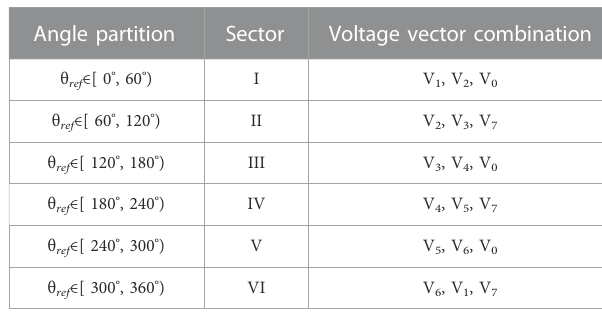
TABLE 1 Voltage vector combination